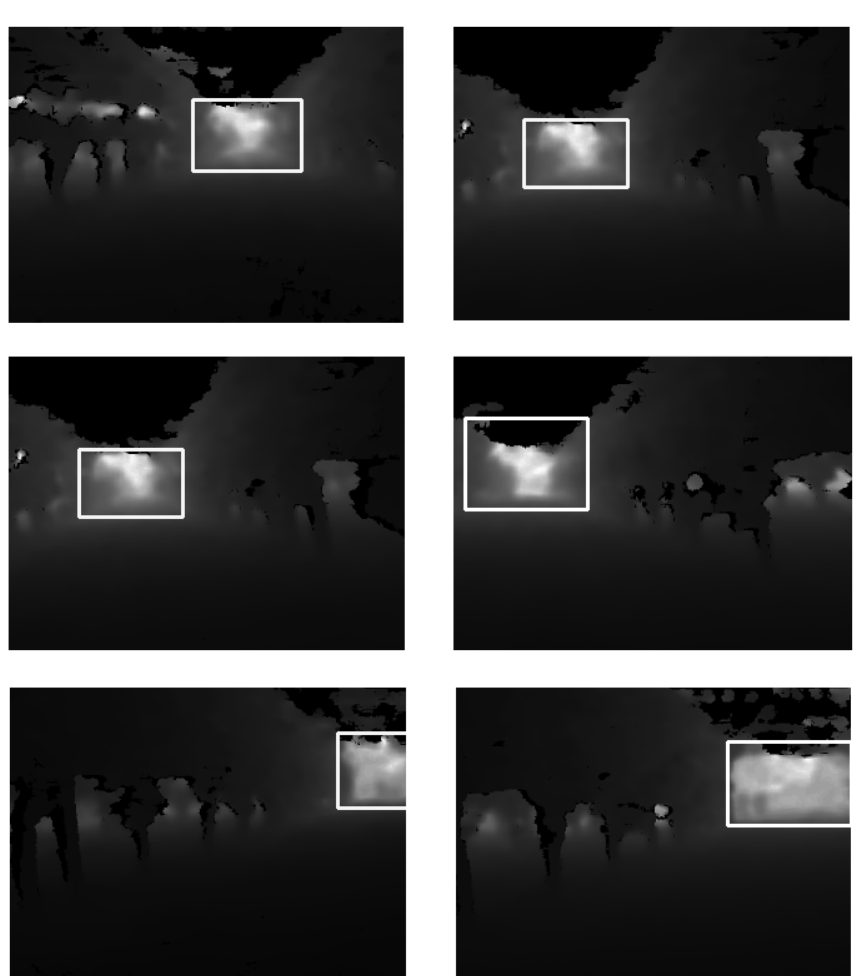
Figure 9. Instances of the depth-map based algorithm while performing tests in the vineyards. Wherever the robot is pointing at, it is capable of correctly detecting the end of the vineyard